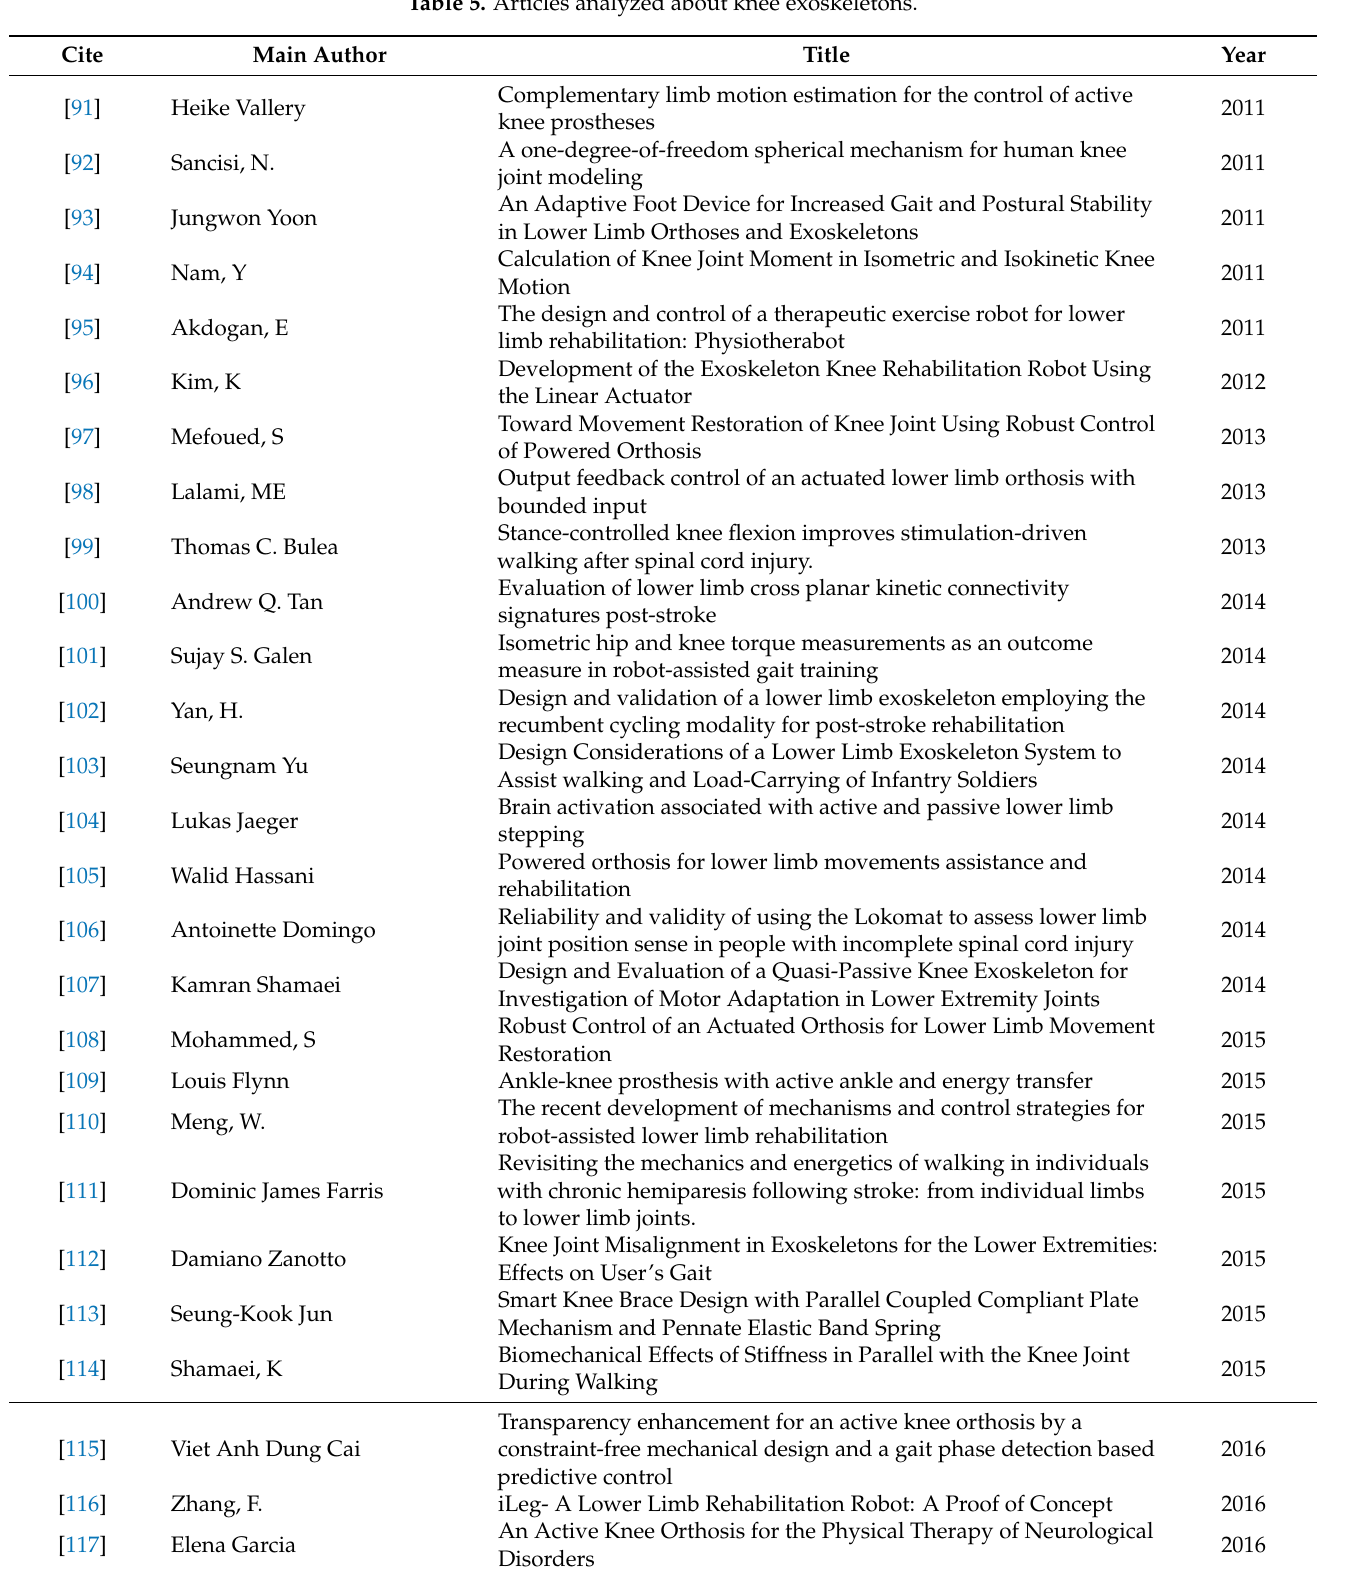
Table 5. Articles analyzed about knee